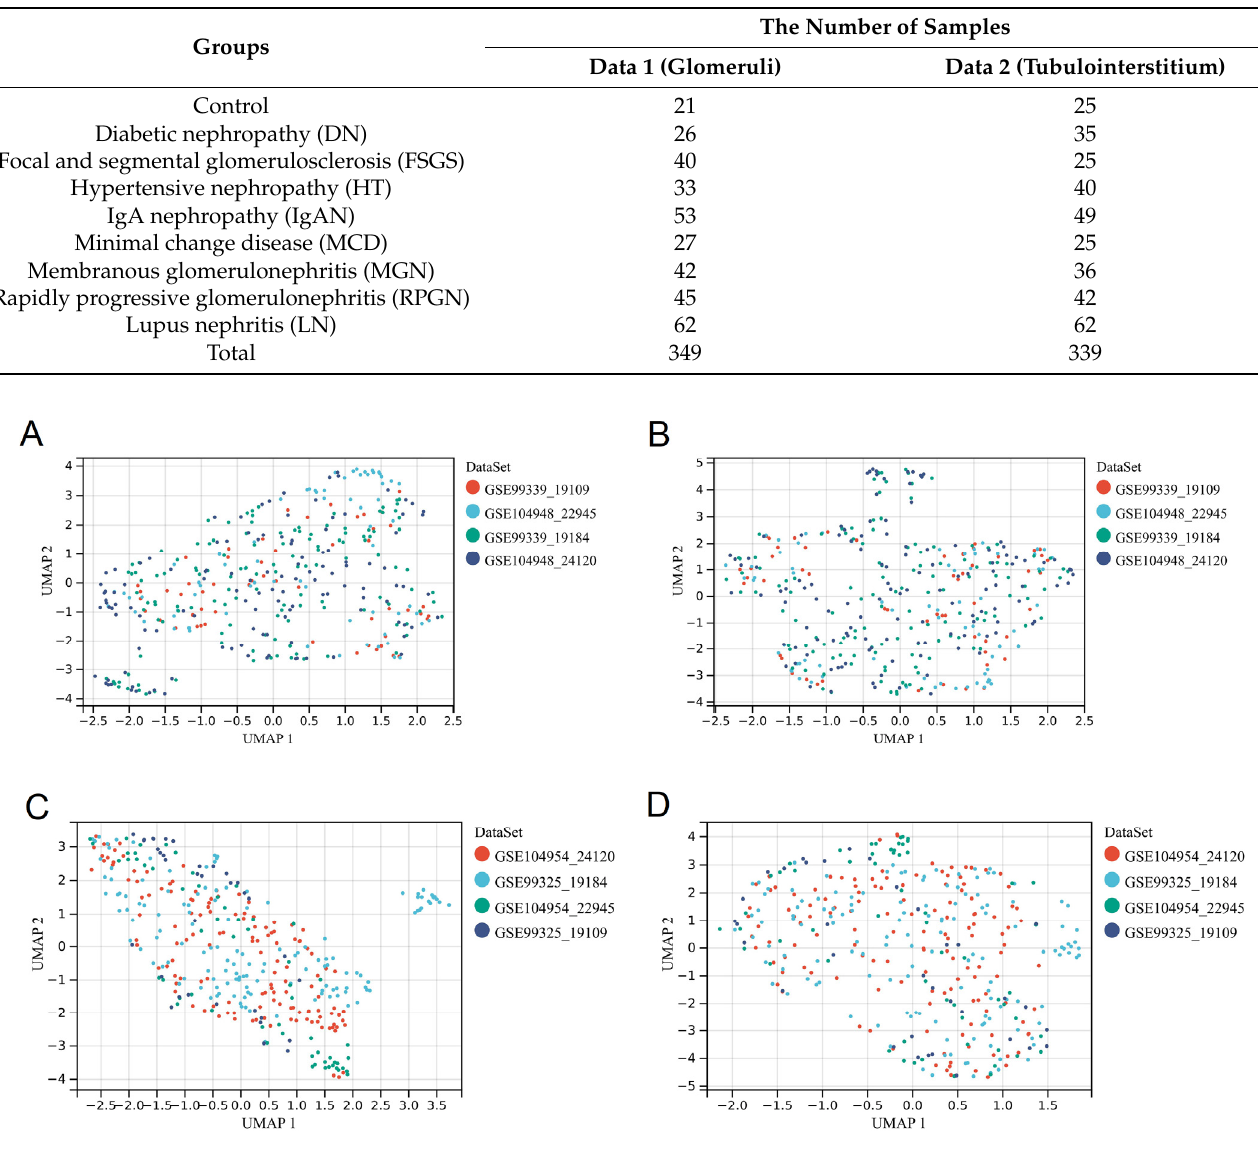
Figure 1. Merging datasets and removing batch effect. ( A ) The UMAP of sample distribution of each dataset of glomeruli before the removal of batch effect, samples from individual datasets are clustered separately, which indicates the existence of batch effect. ( B ) The UMAP of sample distribution of each dataset of glomeruli after the removal of batch effect, the samples of each datasets are clustered together, suggesting a good removal of batch effect. ( C ) The UMAP of sample distribution of each dataset of tubulointerstitium before the removal of batch effect, samples from individual datasets are clustered separately, which indicates the existence of batch effect. ( D ) The UMAP of sample distribution of each dataset of tubulointerstitium after the removal of batch effect, the samples of each datasets are clustered together, suggesting a good removal of batch effect.